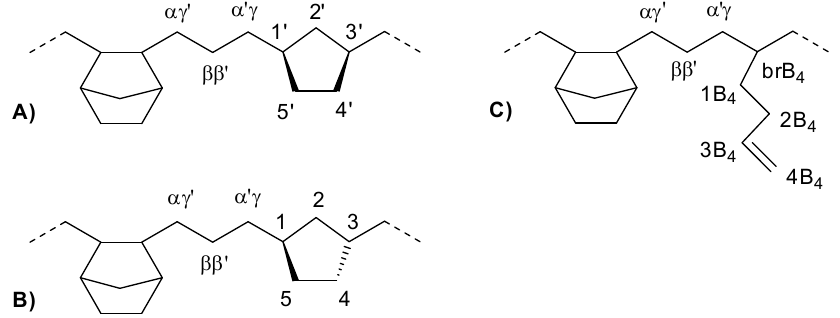
Scheme 10. General molecular structures obtained in poly(E- ter -N- ter -HED) and relative assignment of carbon atoms. ( A ) cis -1,3-cyclopentane unit; ( B ) trans -1,3-cyclopentane unit; ( C ) 1-butenyl branch.